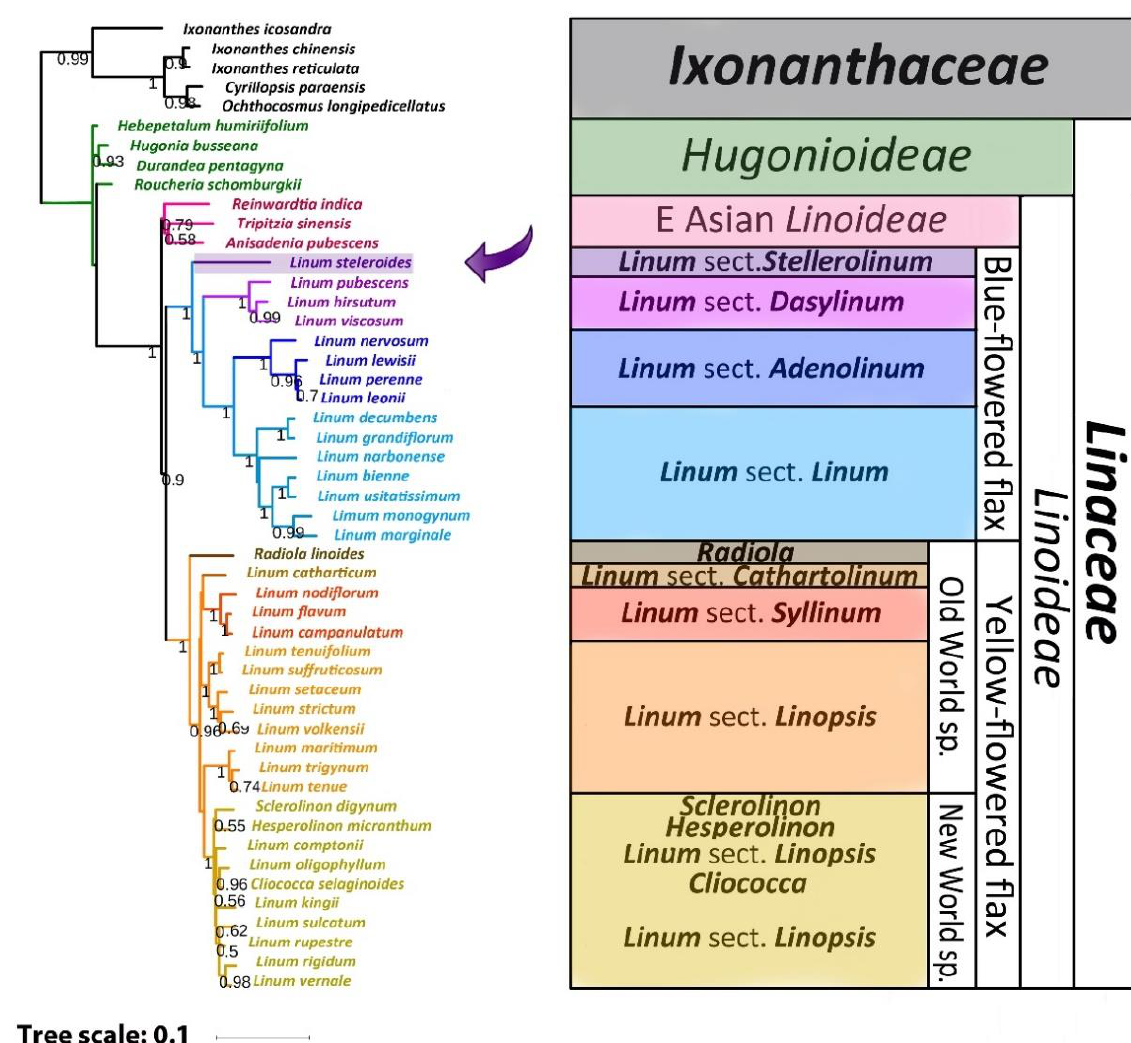
Figure 3. Bayesian phylogeny of 11 loci of 45 Linaceae taxa and the selected outgroup of 5 Ixonanthaceae taxa. The values shown above or below branches are the node supports assessed by the Bayesian-like modification of the approximate likelihood ratio test (aBayes). The position of L. stelleroides is marked with an arrow.